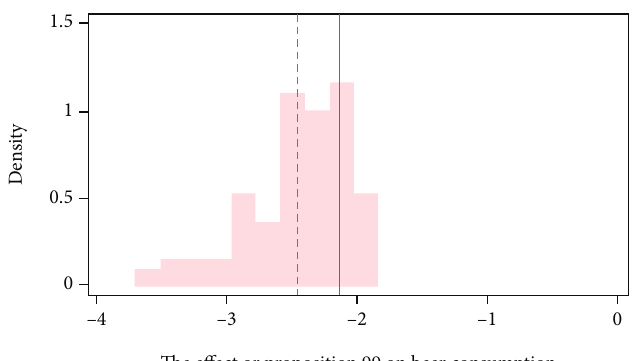
Figure 2: The results from the bootstrapping